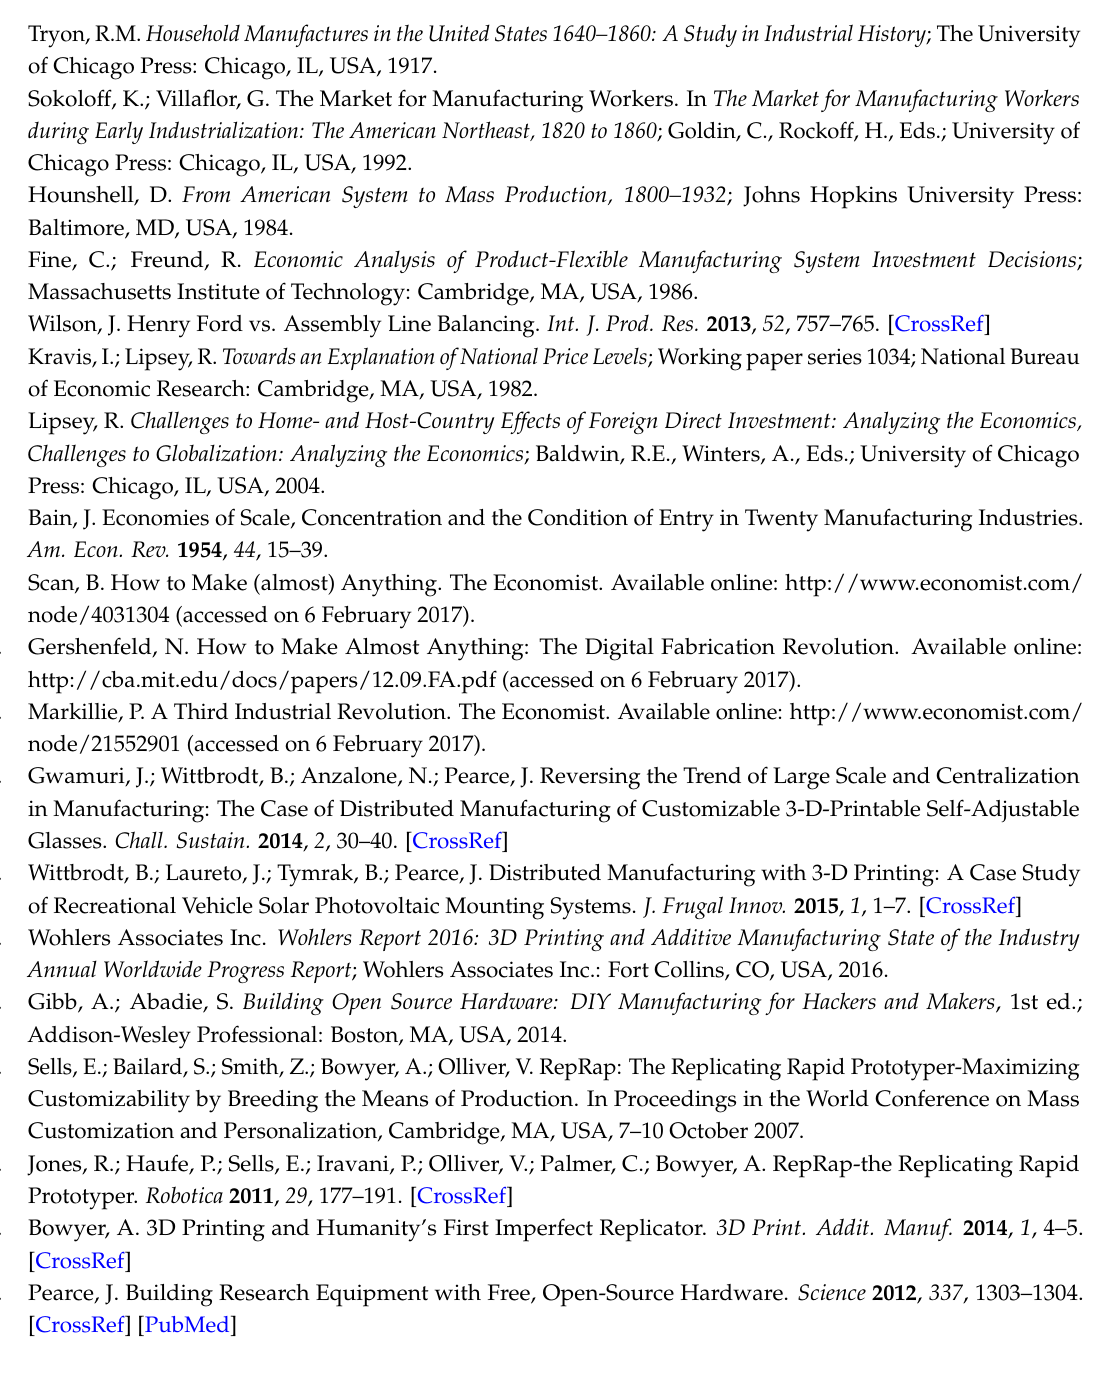
Table S1: Sources of design files and low and high retail